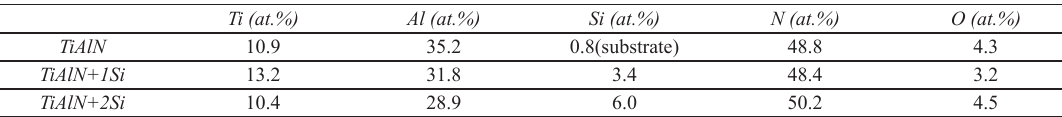
Table 2. Compositions of the (Al,Ti,Si) N films (at.%) analyzed by EDX. Ti